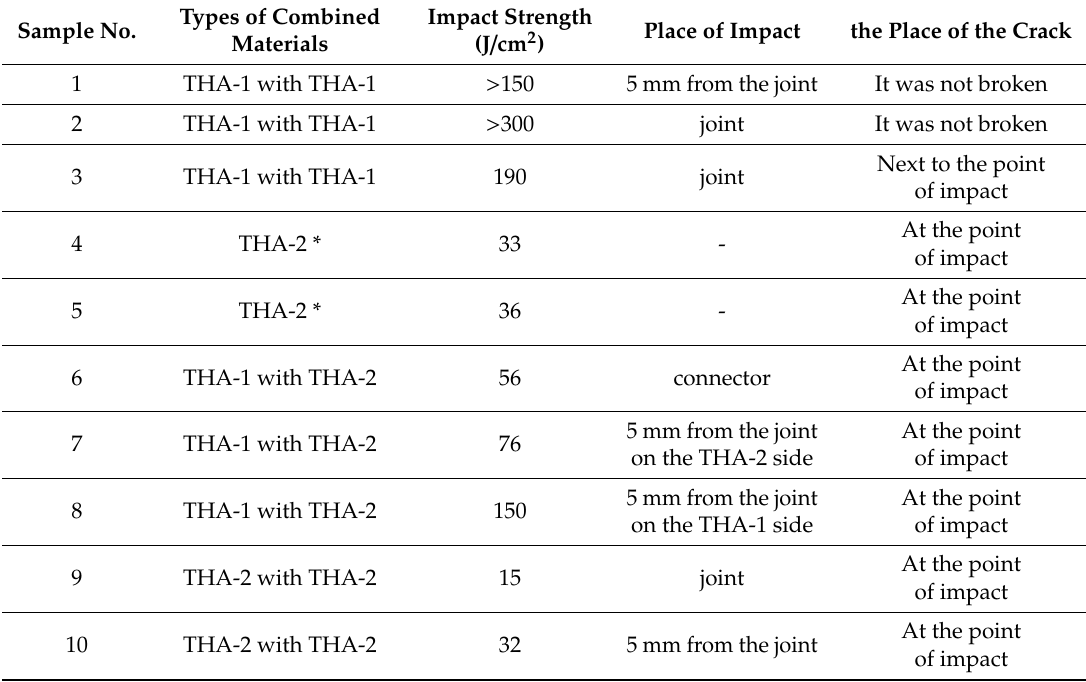
Table 4. Impact test